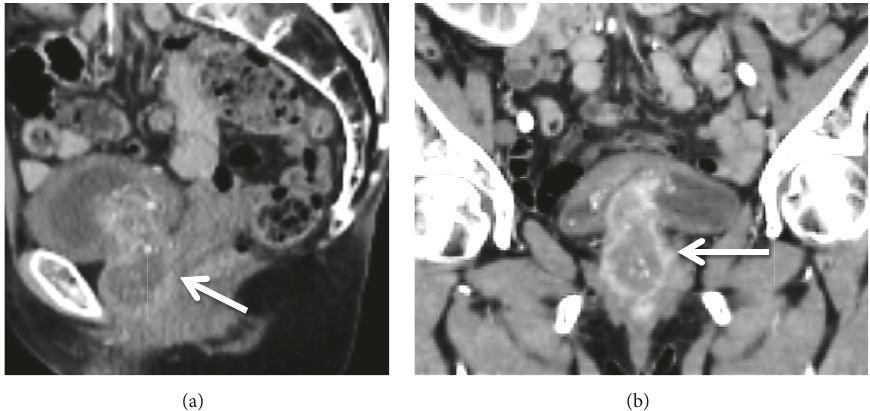
Figure 1: Abdominal enhanced computed tomography images showing a 3.0 × 5.0 cm mass with a heterogeneous contrasting effect between the urethra and bladder neck. (a) Sagittal section (arrow indicates tumor). (b) Coronal section (arrow indicates tumor).